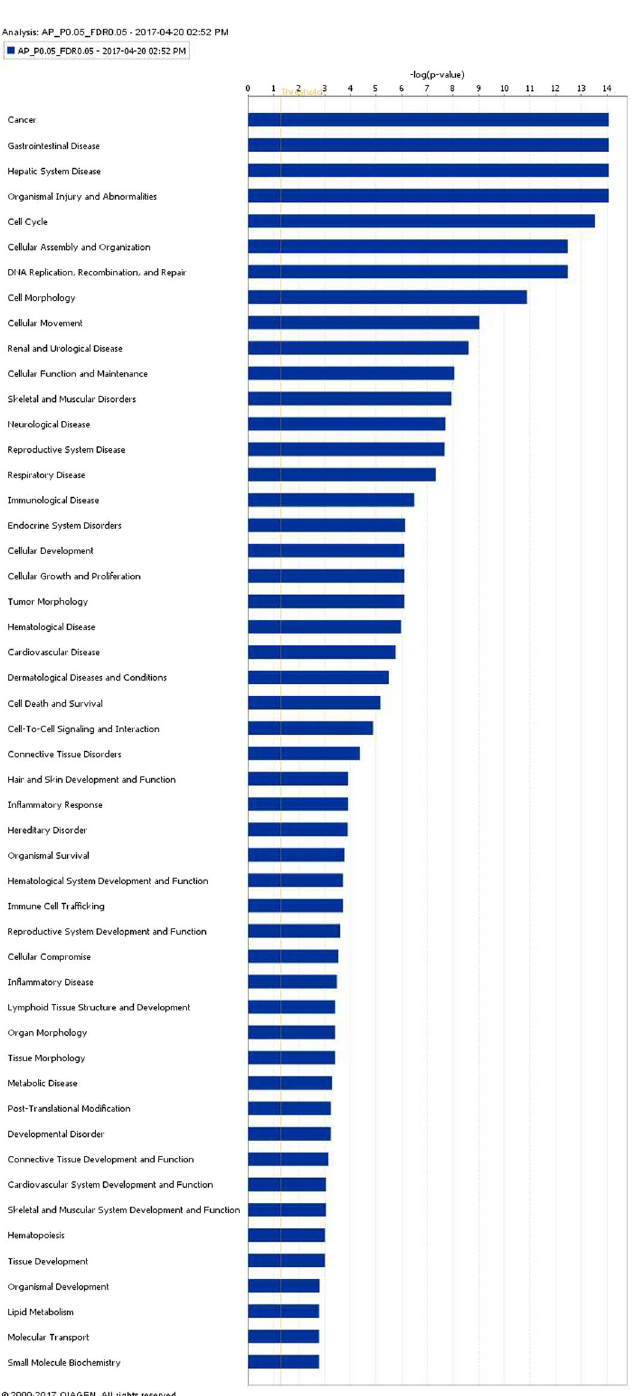
Figure 3. Molecular and cellular function of differentially expressed genes in anterior pituitary tissue of Holstein-Friesian bull calves offered either a low or a high plane of nutrition and and slaughtered at 18 weeks of age. The bars indicate the likelihood [ − log (P-value)] that the specific molecular and cellular function was affected by a high plane of nutrition. The threshold line in the bar chart represents a p-value of 0.05. Data were analyzed through the use of IPA (QIAGEN Inc., https://www.qiagenbioinformatics.com/products/ ingenuitypathway-analysis) 51